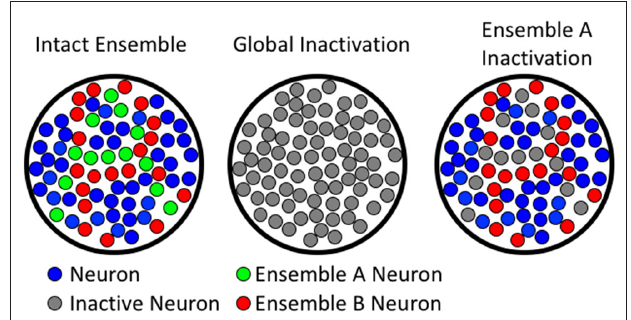
FIGURE 2 | Comparing global to ensemble-specific inactivation. The left column shows hypothetical neuronal ensembles. The middle column illustrates that global inactivation inactivates all neurons (both ensemble A and B). The right column shows ensemble-specific inactivation of ensemble A, leaving ensemble B